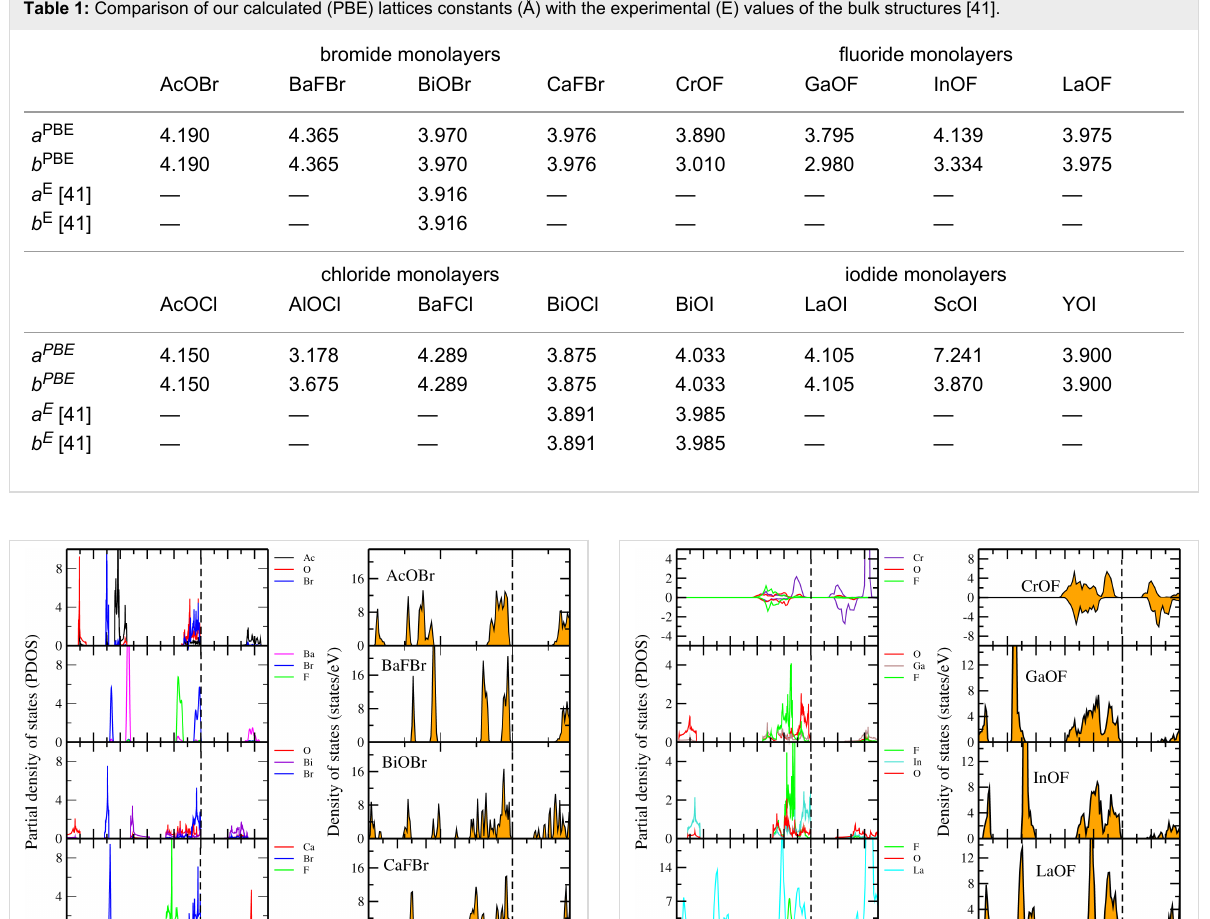
Table 1: Comparison of our calculated (PBE) lattices constants (Å) with the experimental (E) values of the bulk structures [41].